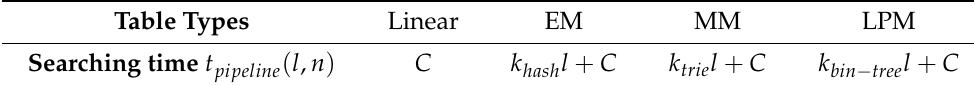
Table 2. Searching time of different MATs. Table Types Linear EM MM LPM Searching time t pipeline ( l , n ) C k hash l + C k trie l +